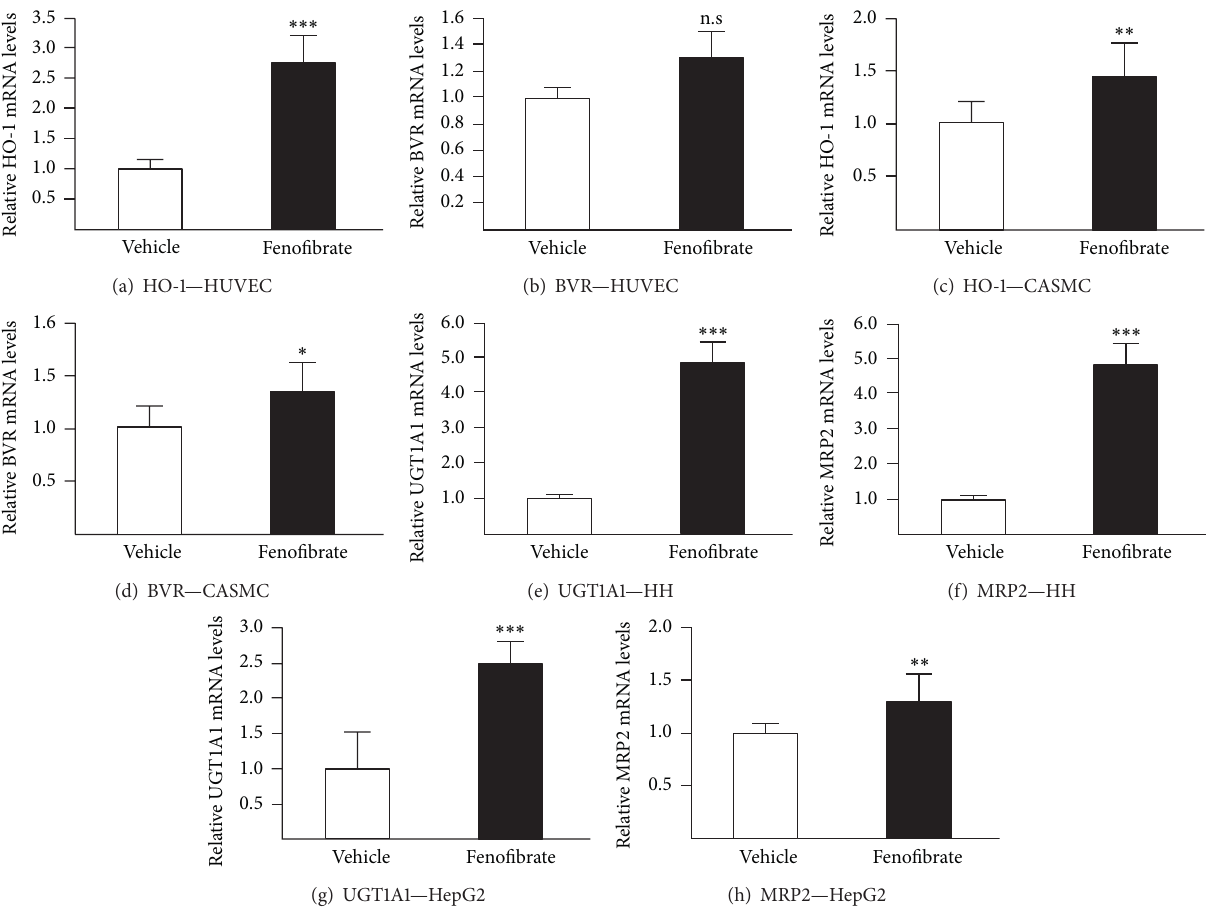
Figure 2: Fenofibrate increases HO-1, UGT1A1, and MRP2 mRNA levels in human vascular and hepatic cell models. Human umbilical vein endothelial cells (HUVEC) (a and b), coronary artery smooth muscle cells (CASMC) (c and d), human hepatocytes (HH; donor 2) (e and f), and HepG2 cells (g and h) were treated with vehicle (DMSO, 0.1%, v/v) or fenofibrate (250 𝜇 M) for 24 H (HUVEC and HH) or 48 H (CASMC and HepG2). Messenger RNA levels were quantified from total RNA through quantitative RT-PCR analyses and normalized with thehousekeepingRNA28S.Values(mean ± SD)areexpressedrelativelytocontrol(vehicle)setat1.Statisticallysignificantdifferencesbetween vehicle- and fenofibrate-treated cells are indicated by asterisks (Student’s 𝑡 -test: ∗ 𝑃 < 0.05 ; ∗∗ 𝑃 < 0.01 ; ∗∗∗ 𝑃 < 0.001 ; n.s: nonsignificant).